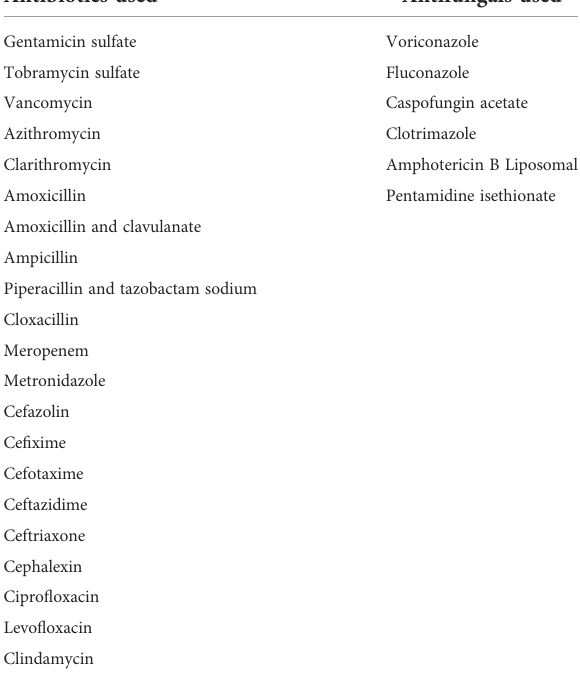
TABLE 2 List of additional antibiotic and antifungals given to